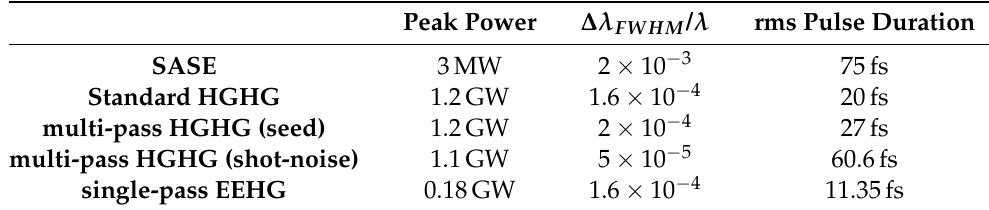
Table 2. Simulation results for final FEL pulse at the same position along amplifier. For the multi-pass simulations, we examine the FEL pulse after 100 passes. For the SASE, we calculate based on the average over 50 simulations with different shot noise. For EEHG, we consider the simulation results of a 2nm output FEL shown in Figure